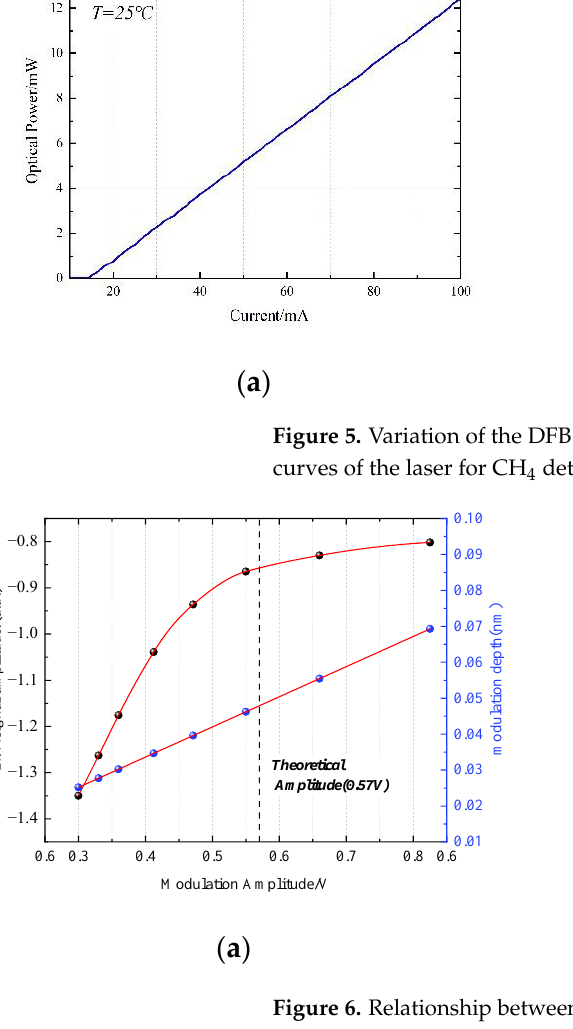
Figure 5. Variation of the DFB laser output power with driving current: ( a ) The P-I (power-current) curves of the laser for CH 4 detection.; ( b ) The P-I curves of the laser for HCl detection.